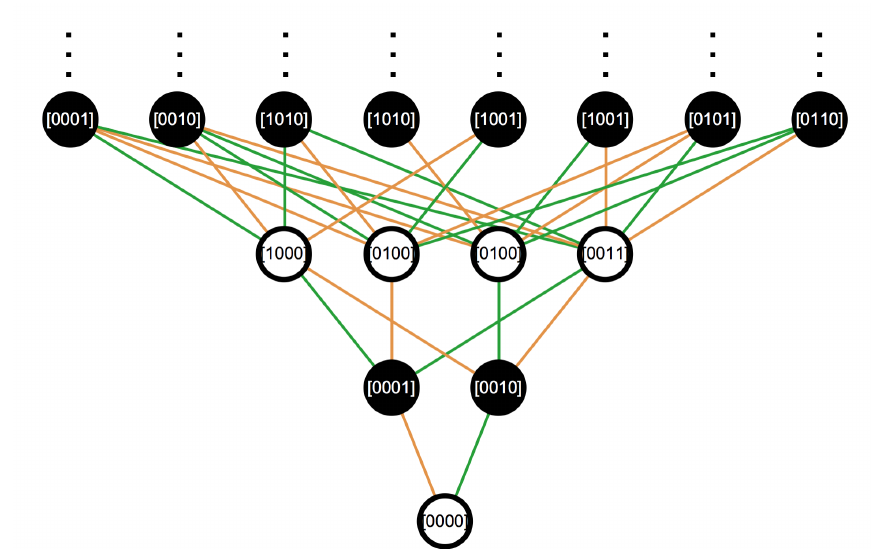
Figure 3 . Adynkra Diagram for 8D minimal scalar